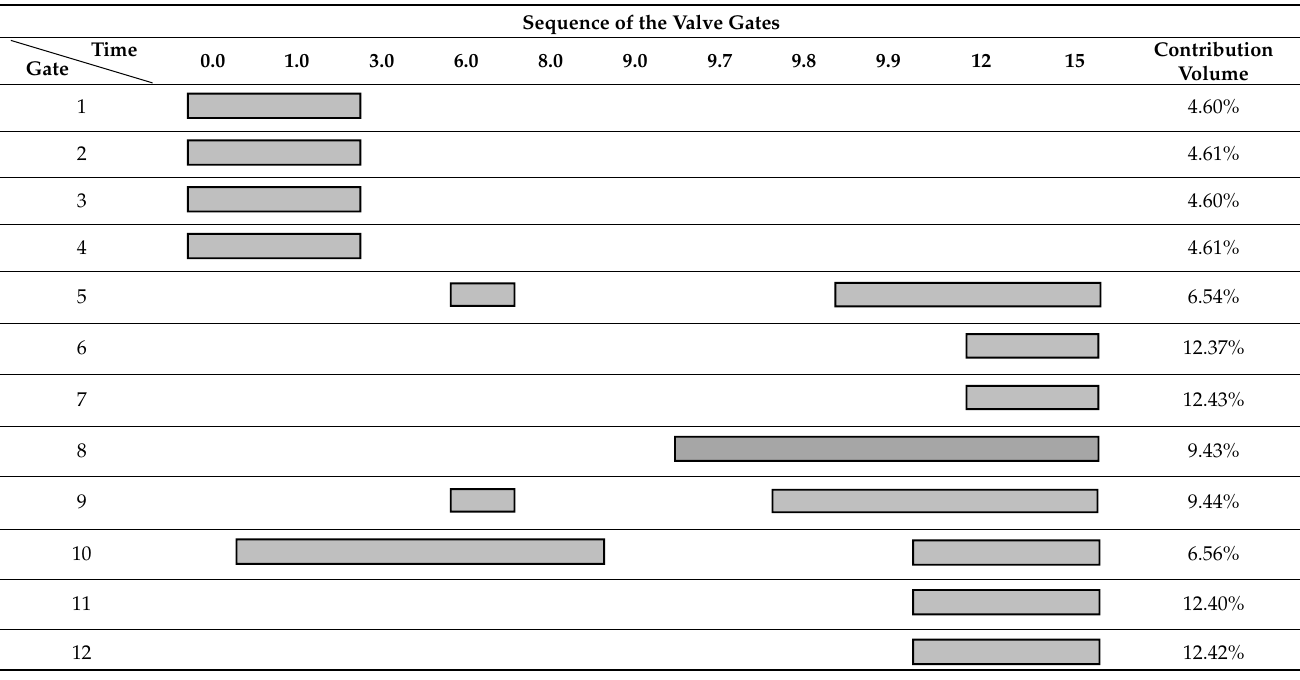
Figure 8. Influence on flatness when lengthening the packing time and shortening the cooling time. Table 3. Switching times of the preset sequence of the filling valve gates. Sequence of the Valve Gates